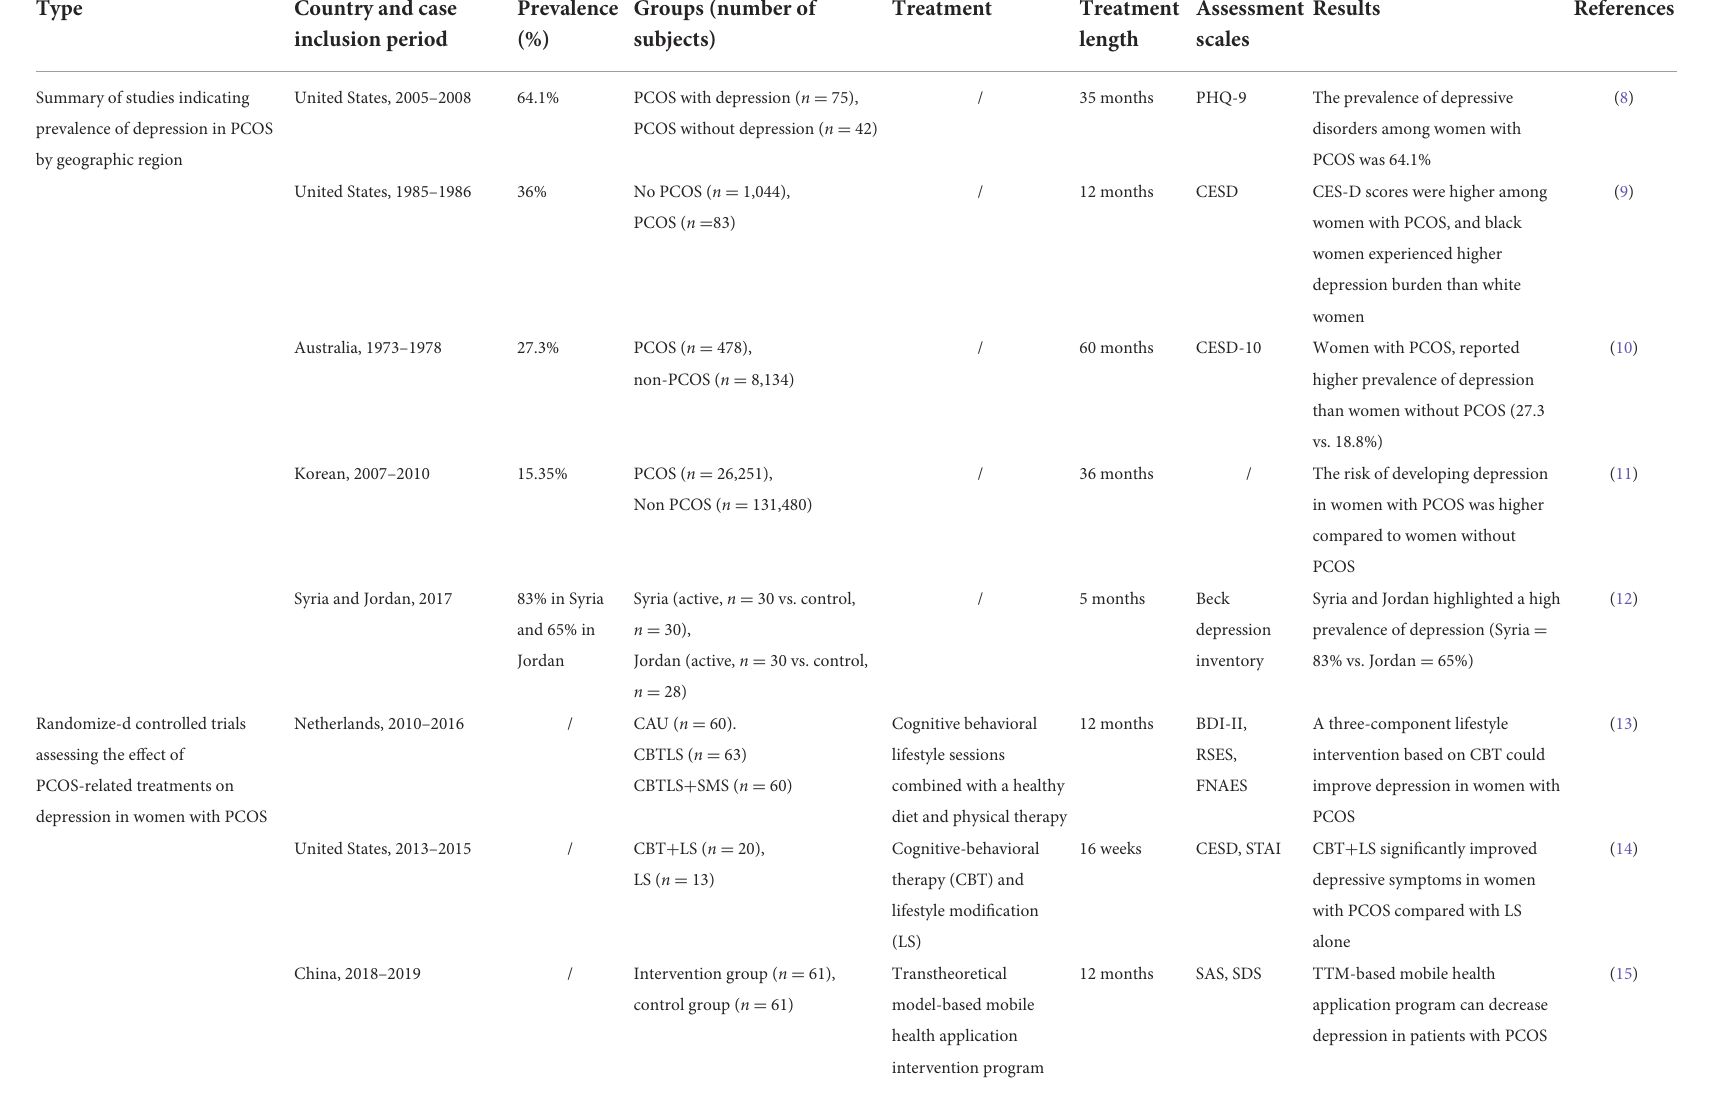
TABLE 1 Summary of studies indicating prevalence by geographic region and examining the impact of PCOS-related treatments on depression in randomized controlled